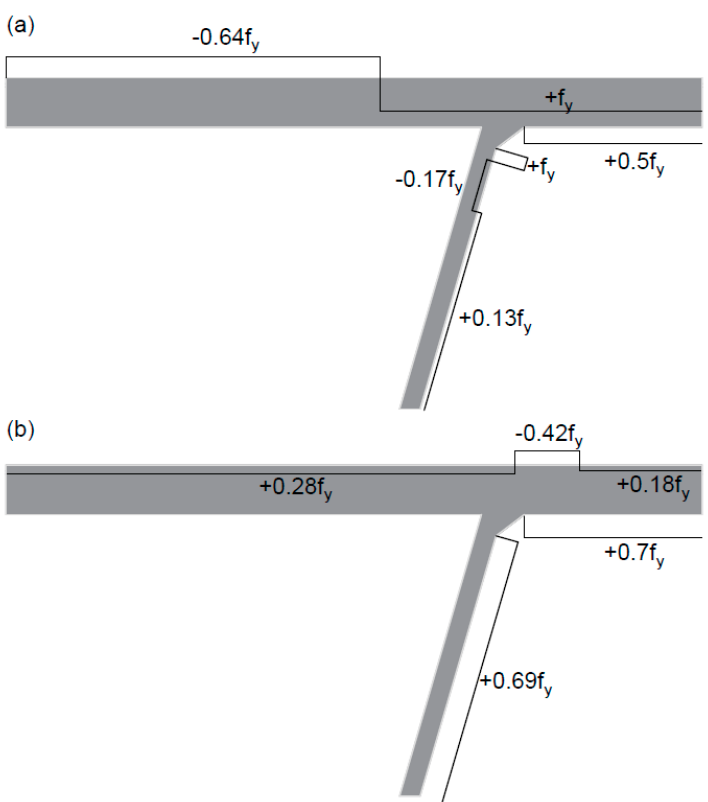
Figure 12. General residual stress distribution of the orthotropic steel deck from experimental measurements (f y = yield strength) for the longitudinal direction ( a ) and the transverse direction ( b ).